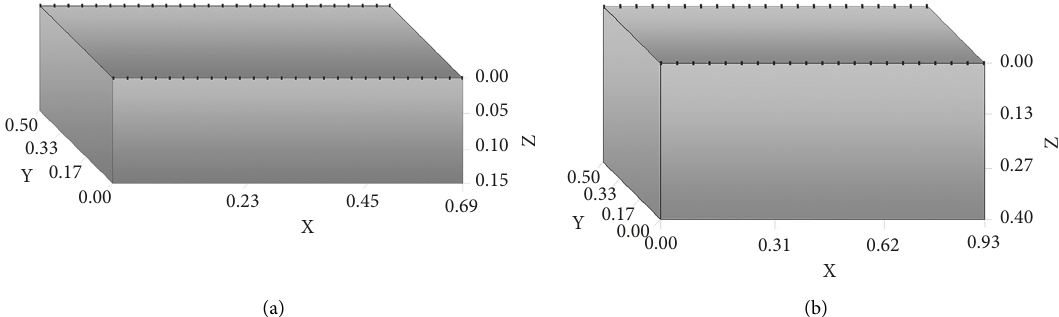
Figure 4: The three-dimensional space coordinate system in the different layers of the model. (a) 15cm above the coal seam and (b) 40cm above the coal seam.